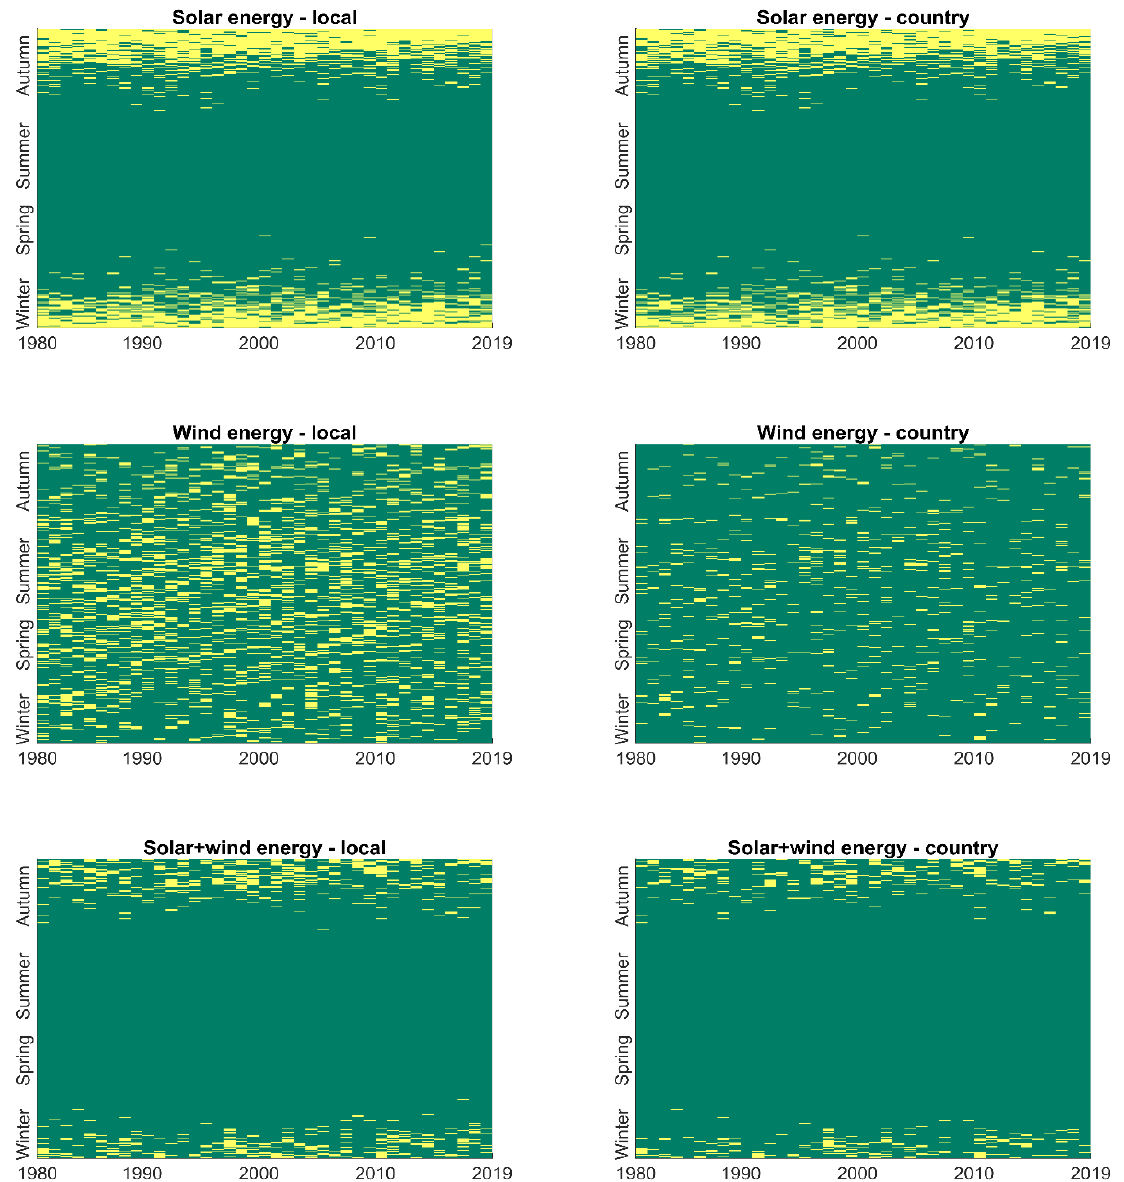
Figure 18. ‘Resource droughts’ (yellow) in Łeba region (central Poland). The left column presents local ‘resource droughts’, where the threshold for classifying a day as a ‘resource drought’ event was based on mean daily resources availability over the years 1980 – 2019. The right column presents a similar analysis, but with the threshold based on national mean (taking into account all grid points within Polish borders).